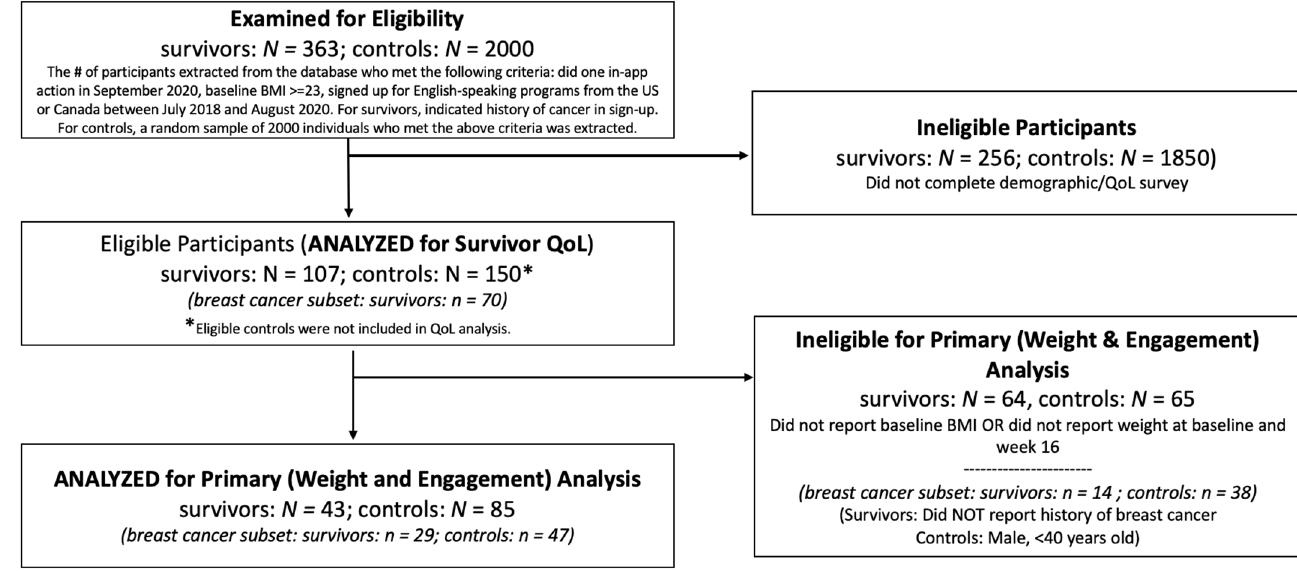
Figure 1. Flow diagram of participant eligibility. N refers to the main sample and n refers to the subsample of breast cancer survivors only.